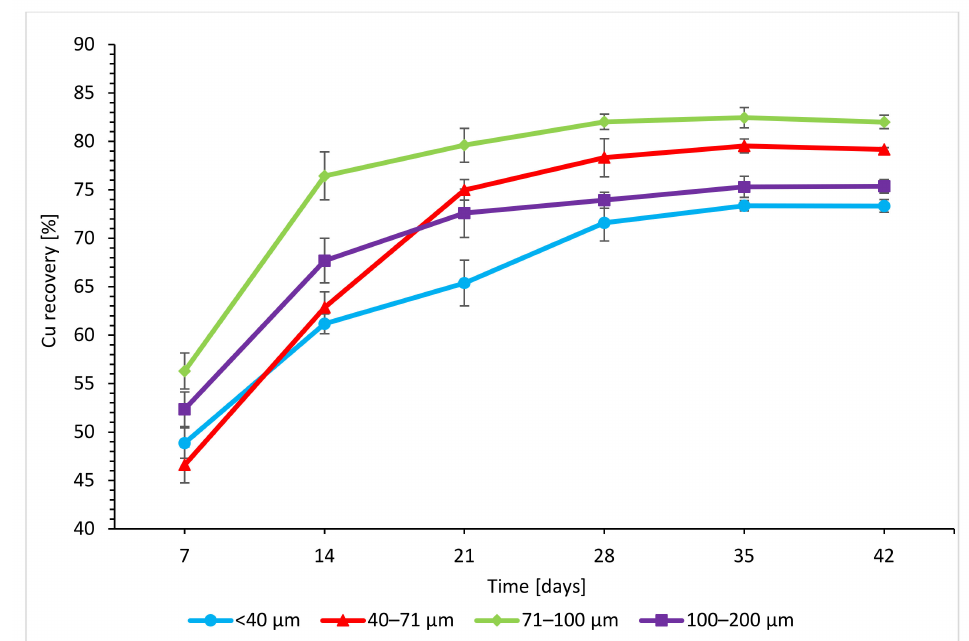
Figure 7. Influence of particle size on Cu recovery (pH 2, stirring speed 100 rpm, and 6.67% ( w / v ) pulp